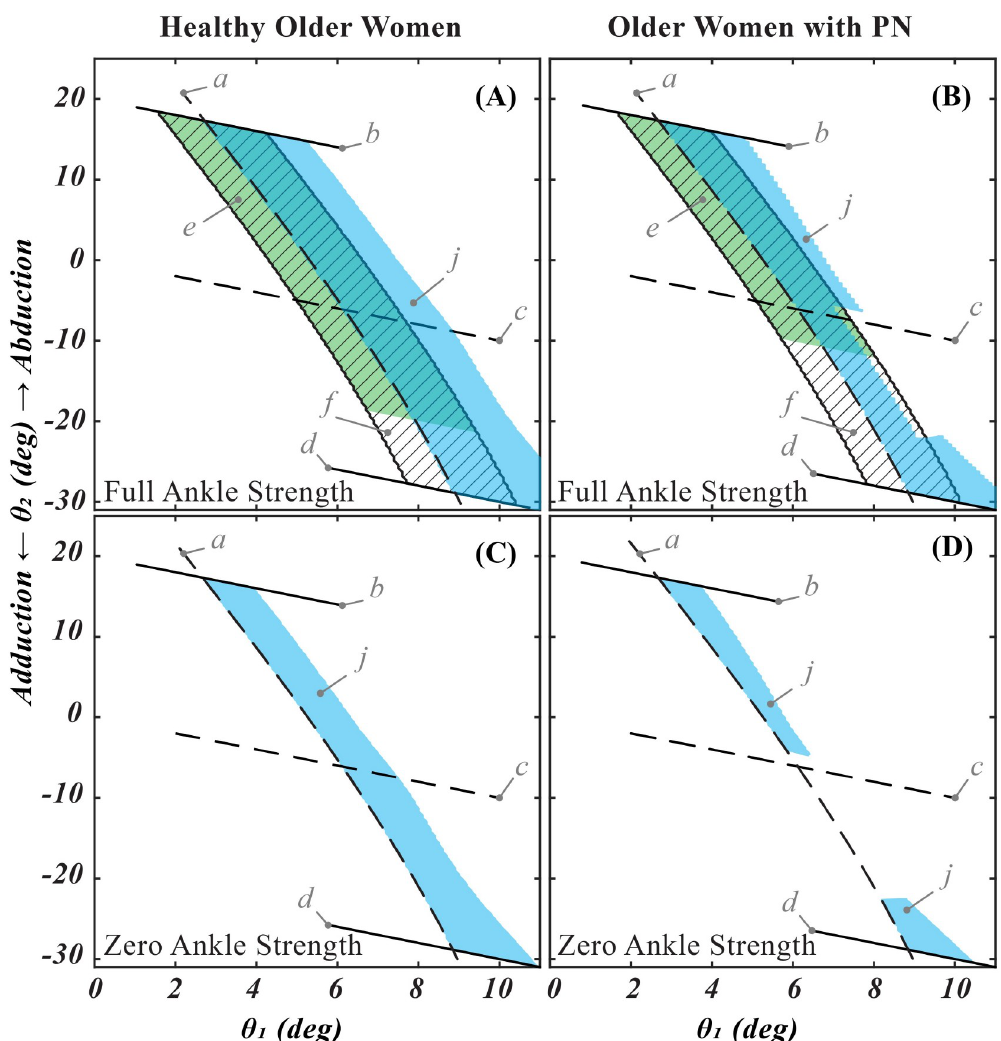
Fig 5. Graphical comparison of calculated active and net FBR with recoverable laterally perturbed initial quasistatic OLB states in healthy older women and older women with peripheral neuropathy. Letters a-d show the loci of quasistatic initial states similar to those shown in Fig 3. Letter e (green region) shows the active FBR, derived with only active hip abduction strength. Letter f (region with diagonal lines) shows net FBR derived with both active and passive hip abduction moment. Letter j (blue region) shows laterally perturbed initial quasistatic states which can be recovered by a strategy involving maximum acceleration of the center of mass. We can see that while for both groups the net FBR extends between lines b and d, weaker active hip abduction strength significantly ‘hollows out’ the recoverable states for the older women with PN (A and B). Repeating the simulations with zero ankle inversion / eversion strength collapses both active and net FBR to line a, and shows the same hollowing effect on the recoverable quasistatic states as the simulations with full ankle strength (C and D). Comparing the width of the FBR (top row) and the recoverable quasistatic states when considering no ankle strength (bottom row) shows that the effectiveness of the hip strategy in recovering OLB heavily depends on the maximum hip abduction strength. In the healthy older women, the hip strategy seems as effective as the ankle strategy.